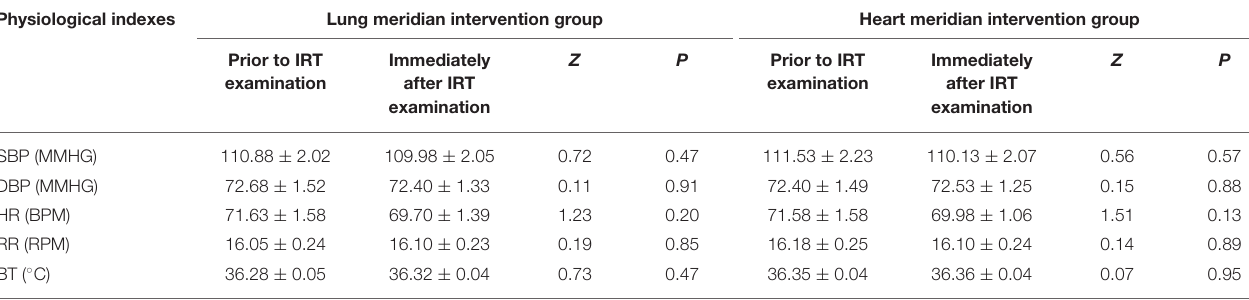
TABLE 2 | Physiological indexes of the study subjects prior to and immediately after IRT examination (mean ± SEM, n = 80). Physiological indexes